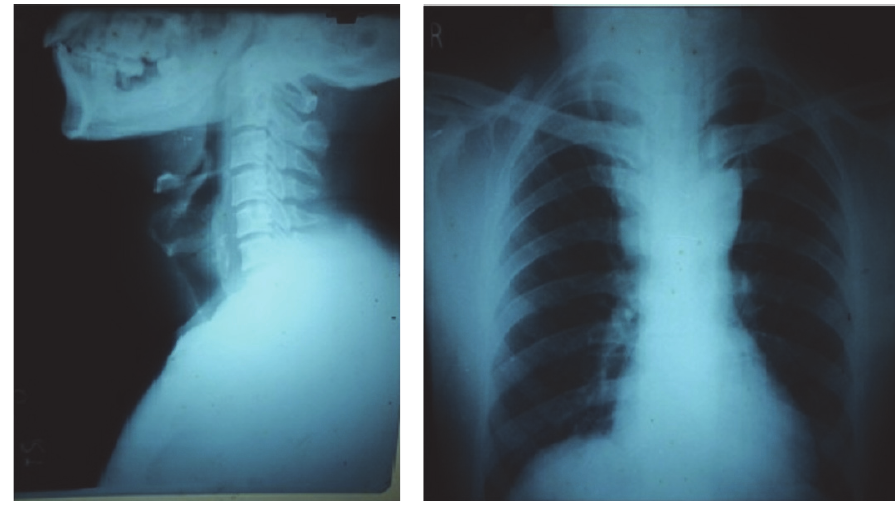
Figure 2: Cervical and thoracic X-rays to look for any obstructive